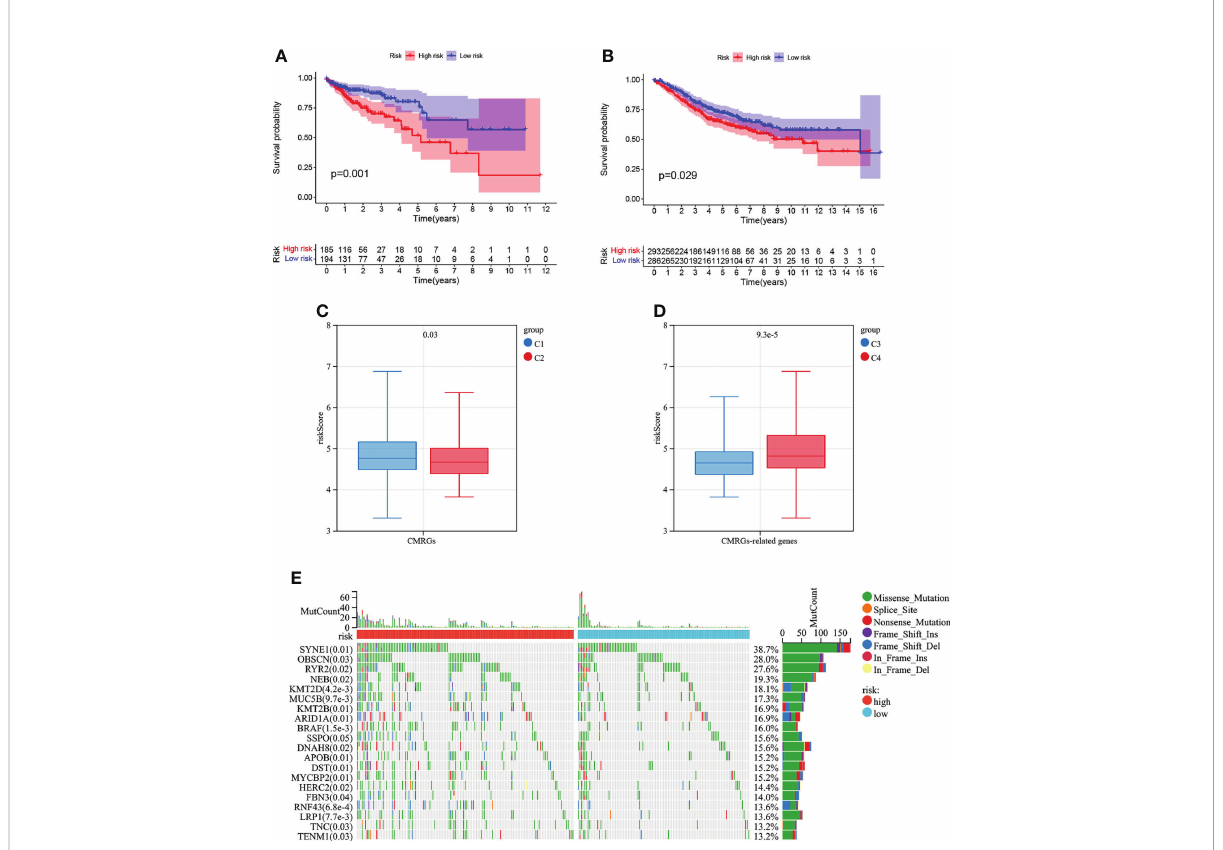
FIGURE 8 Survival analysis of risk models and correlation with COAD subtypes. (A) Analysis of survival differences between high-risk and low-risk COAD patients in TCGA database. (B) Analysis of survival differences between high-risk and low-risk COAD patients in GSE39582. (C) The correlation of risk score with CMRGs pattern. (D) The correlation of risk score with CMRGs-related genes pattern. (E) Genetic mutations between high and low risk